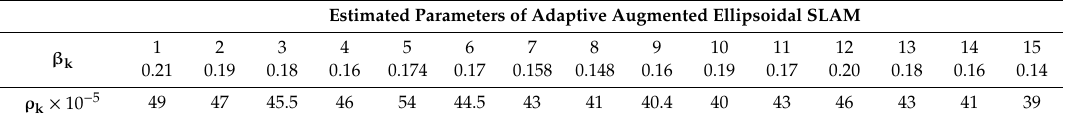
Table 1. Ellipse parameters for adaptive augmented ellipsoidal